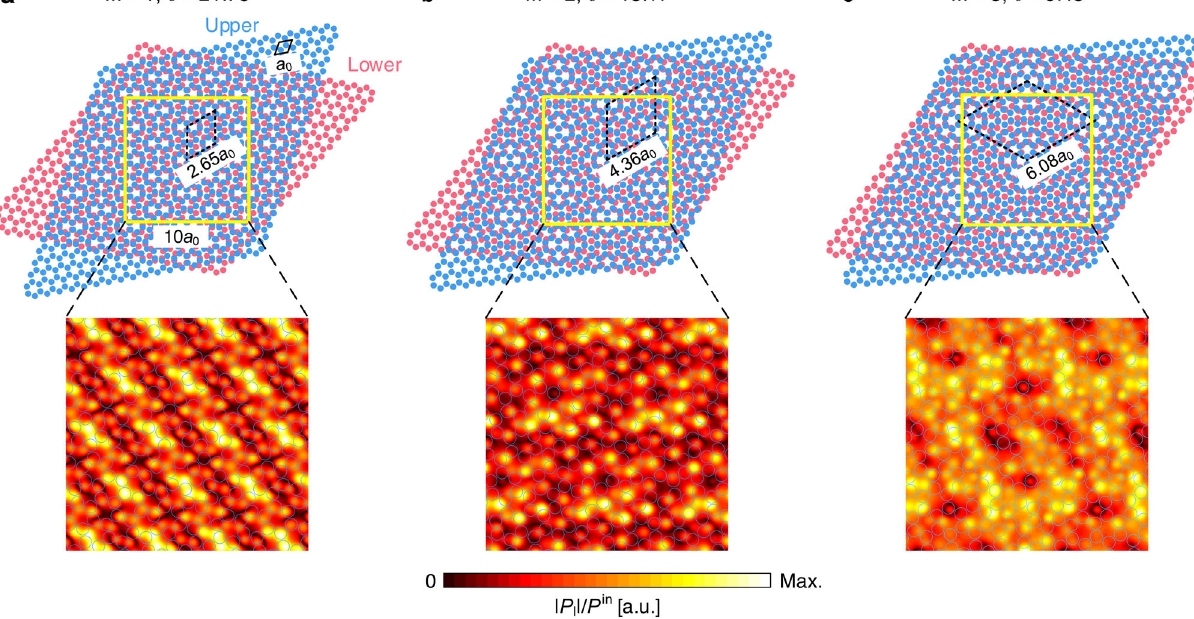
COMMUNICATIONS MATERIALS| (2022) 3:99